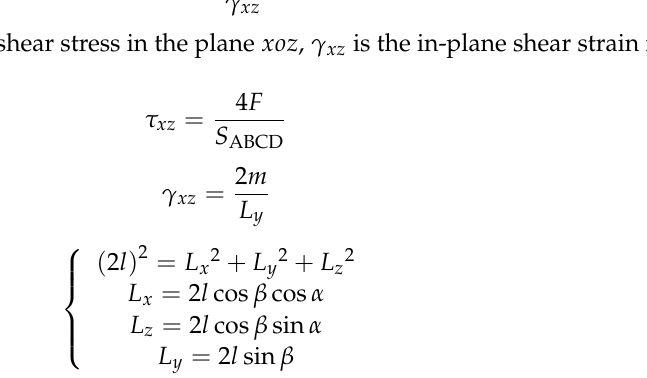
Figure 2. Homogenization equivalent method of BCC lattice structure. For the red bar AO (cid:48) , the equivalent shear modulus of the force F acting on the xoz plane is: